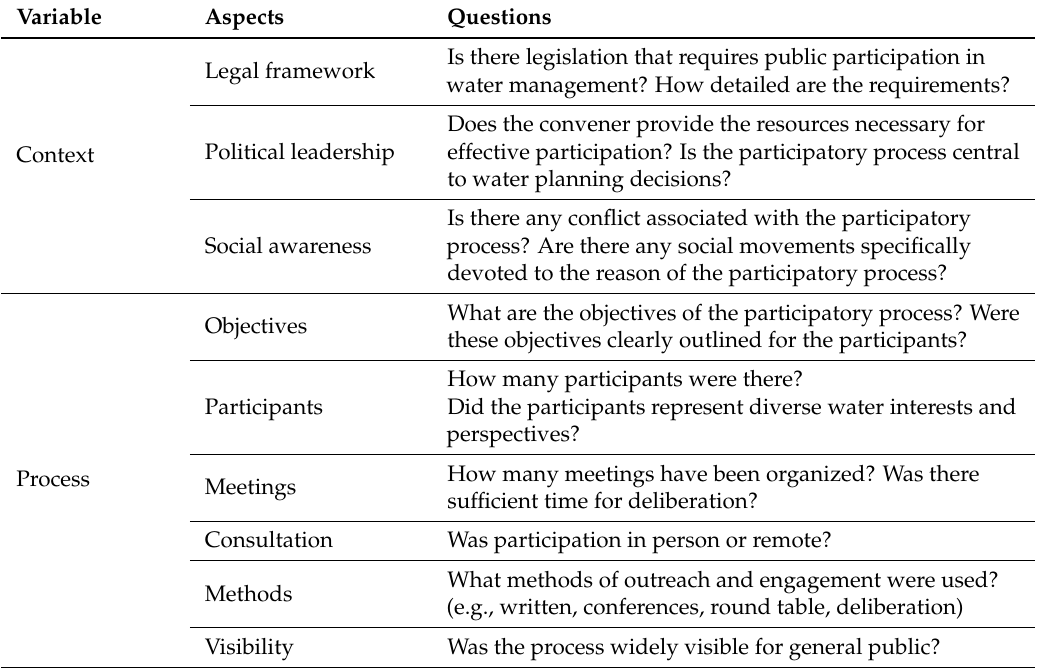
Table 3. Context and process aspects and study